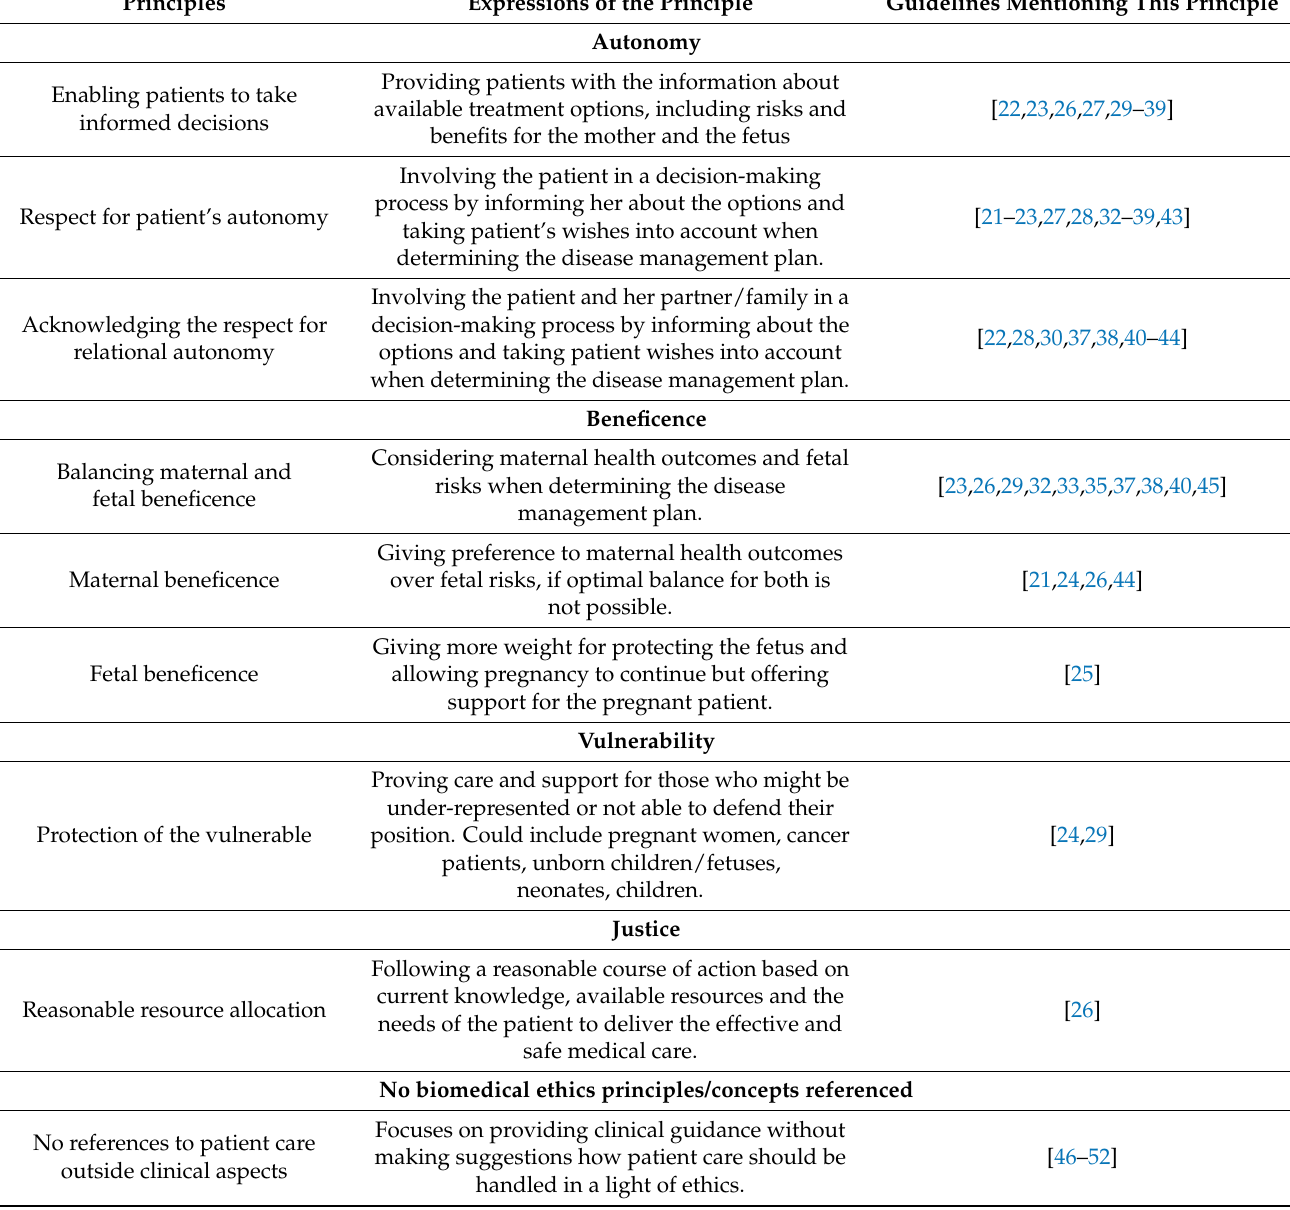
Table 1. Main biomedical ethics concepts/principles identified in the